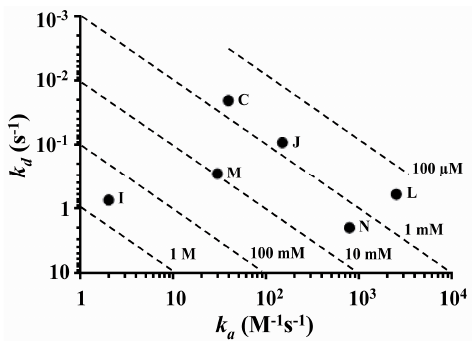
Figure 2. Kinetic profile plot of the six test compounds; Compounds: ( C ) gallic acid; ( I ) doxorubicin; ( J ) acteoside; ( L ) salvianolic acid B; ( M ) echinacoside; and ( N ) vincristine. The diagonal dashed lines represented the equilibrium dissociation constant (KD).